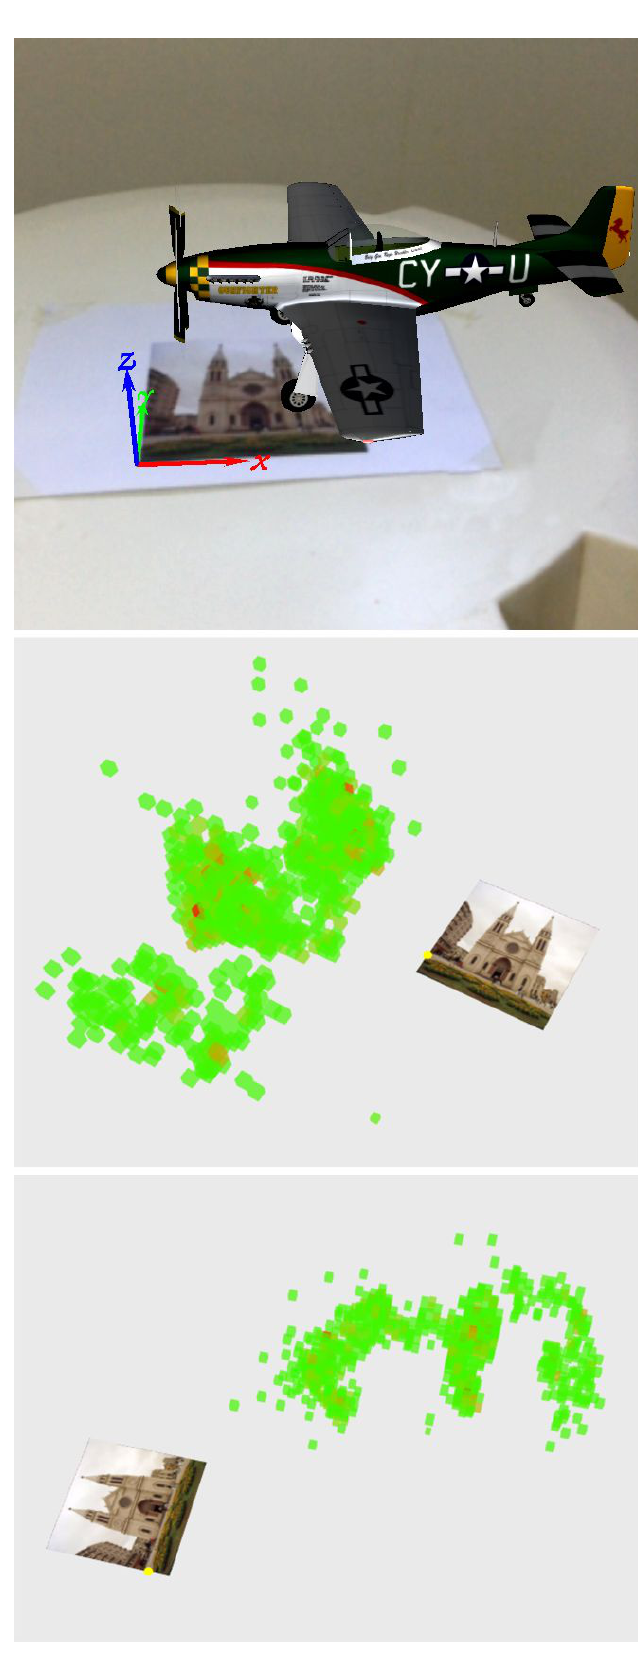
Figure 12. The top image was captured from an iPad, representing a user following the 2D path on the marker. The middle and bottom images show two different views of the 3D points captured by the